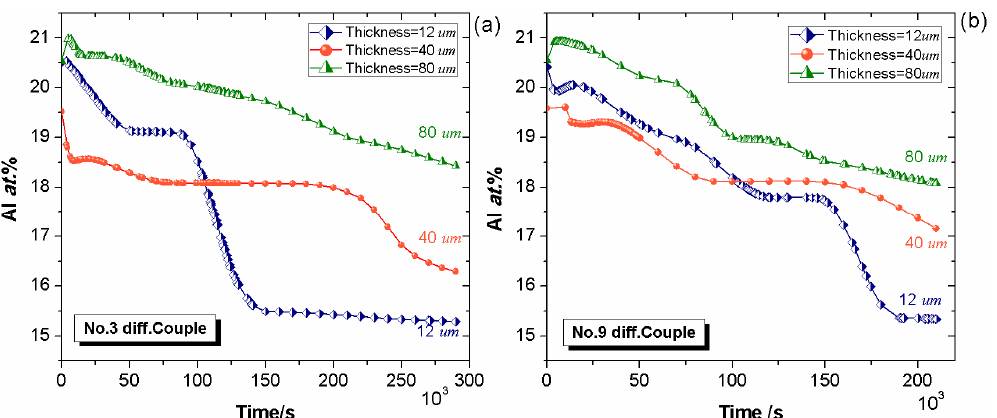
Figure 15. Average surface concentration evolution of component Al for bond coat/substrate systems with different thickness with an effect of temperature gradient ( Δ G = 5000 K/cm): ( a ) No. 3, and ( b ) No. 9.